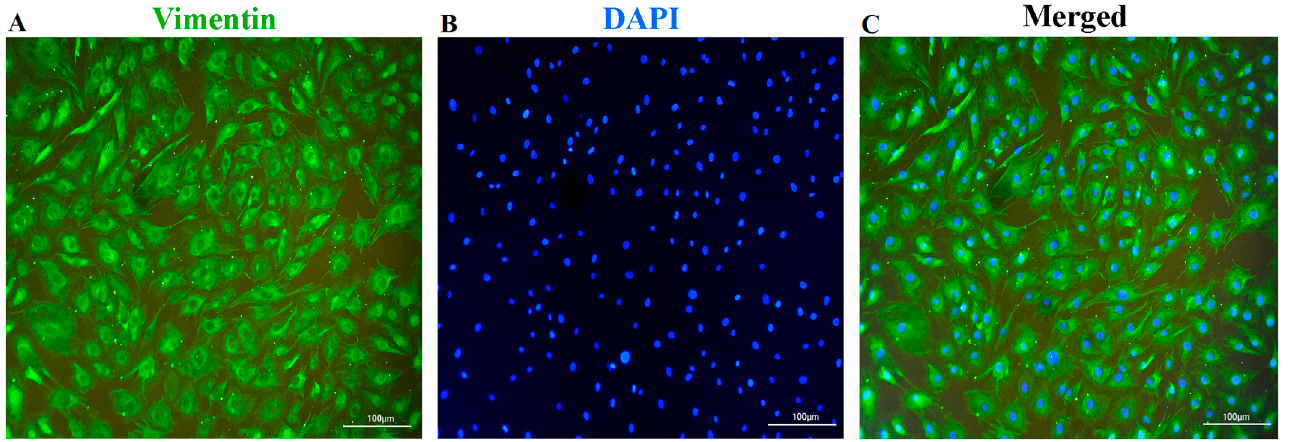
Figure 1. Vimentin-immuno fl uorescence staining of cells. ( A ). Cells stained by vimentin antibody. ( B ). Nucleus labeled with DAPI. ( C ). Merged images.